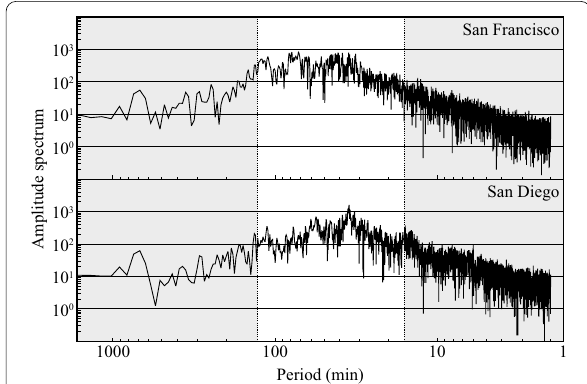
Fig. 3 Amplitude spectrums for the observed waveforms including the both Ansei–Tokai and Ansei–Nankai tsunami events (from 3 am 23 December until 7 am 26 December) at the San Francisco and San Diego tide gauge stations. Portions of the energy band removed by application of the low- and high-bandpass filters (cut-off periods of 16 and 128 min, respectively) are shaded gray